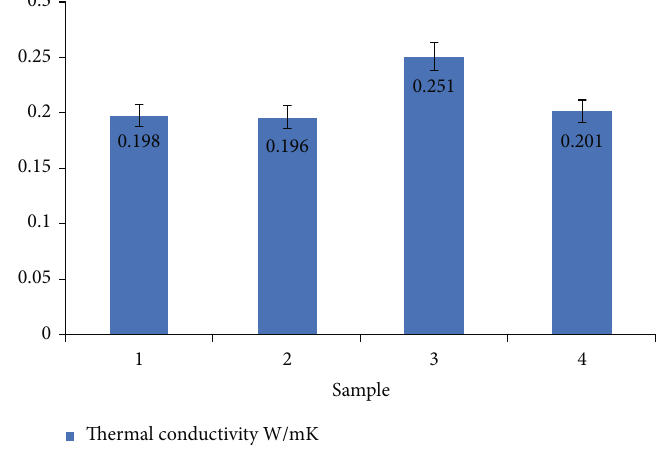
Figure 7: Thermal conductivity of hybrid